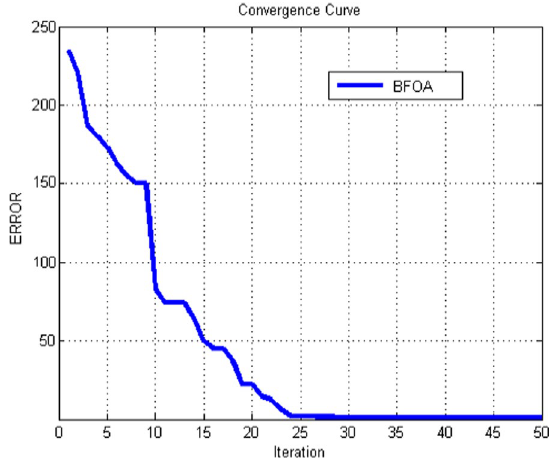
Fig. 6 The controller error with BFO iterations